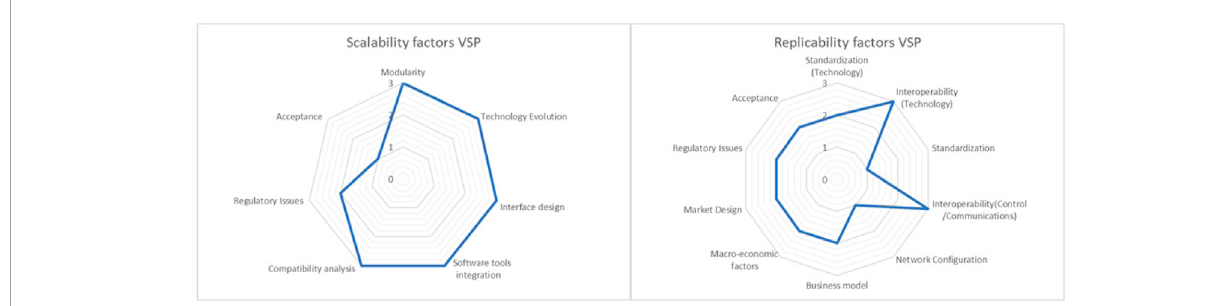
FIGURE 6 Spider graph on VSP scalability and replicability assessments.